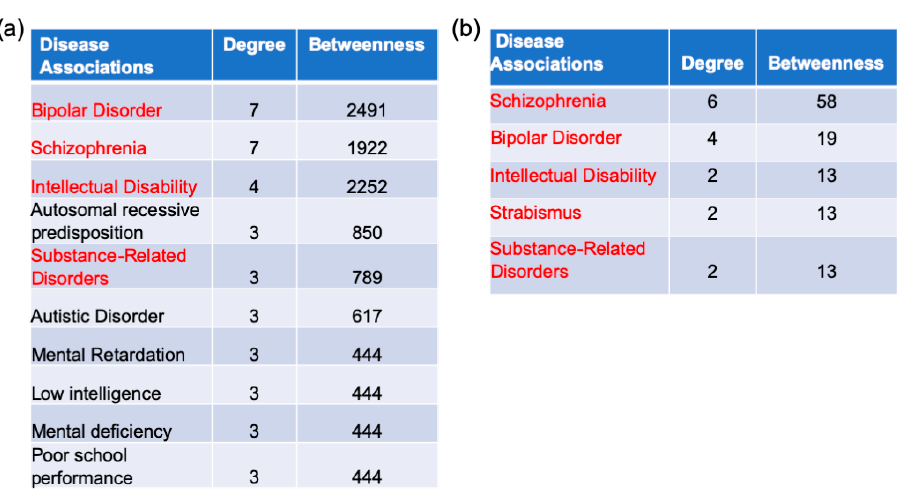
Figure 7. Disease association analysis. The list of top 10 disease associations, ranked by degree and betweenness, obtained from AD/healthy and AD/AsymAD switch genes is shown in ( a , b ). The associated diseases shared between both analyses are indicated in red.